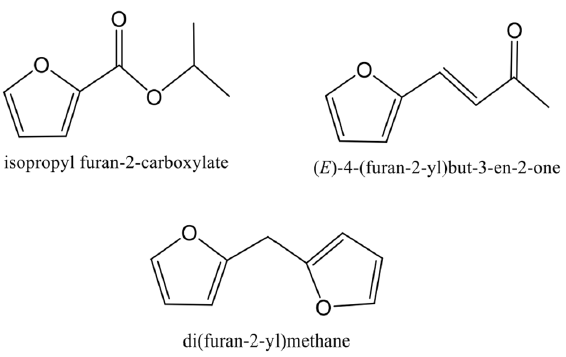
Figure 6. Undesired products formed from one-pot reaction from FU to GVL.